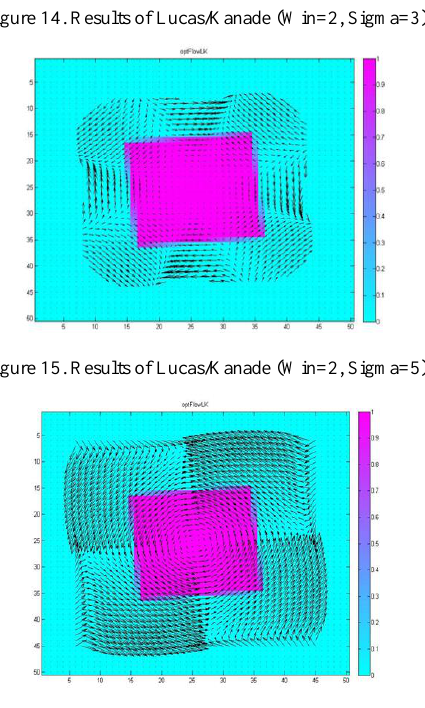
Figure 16. Results of Lucas/Kanade (Win=5, Sigma=0.1)